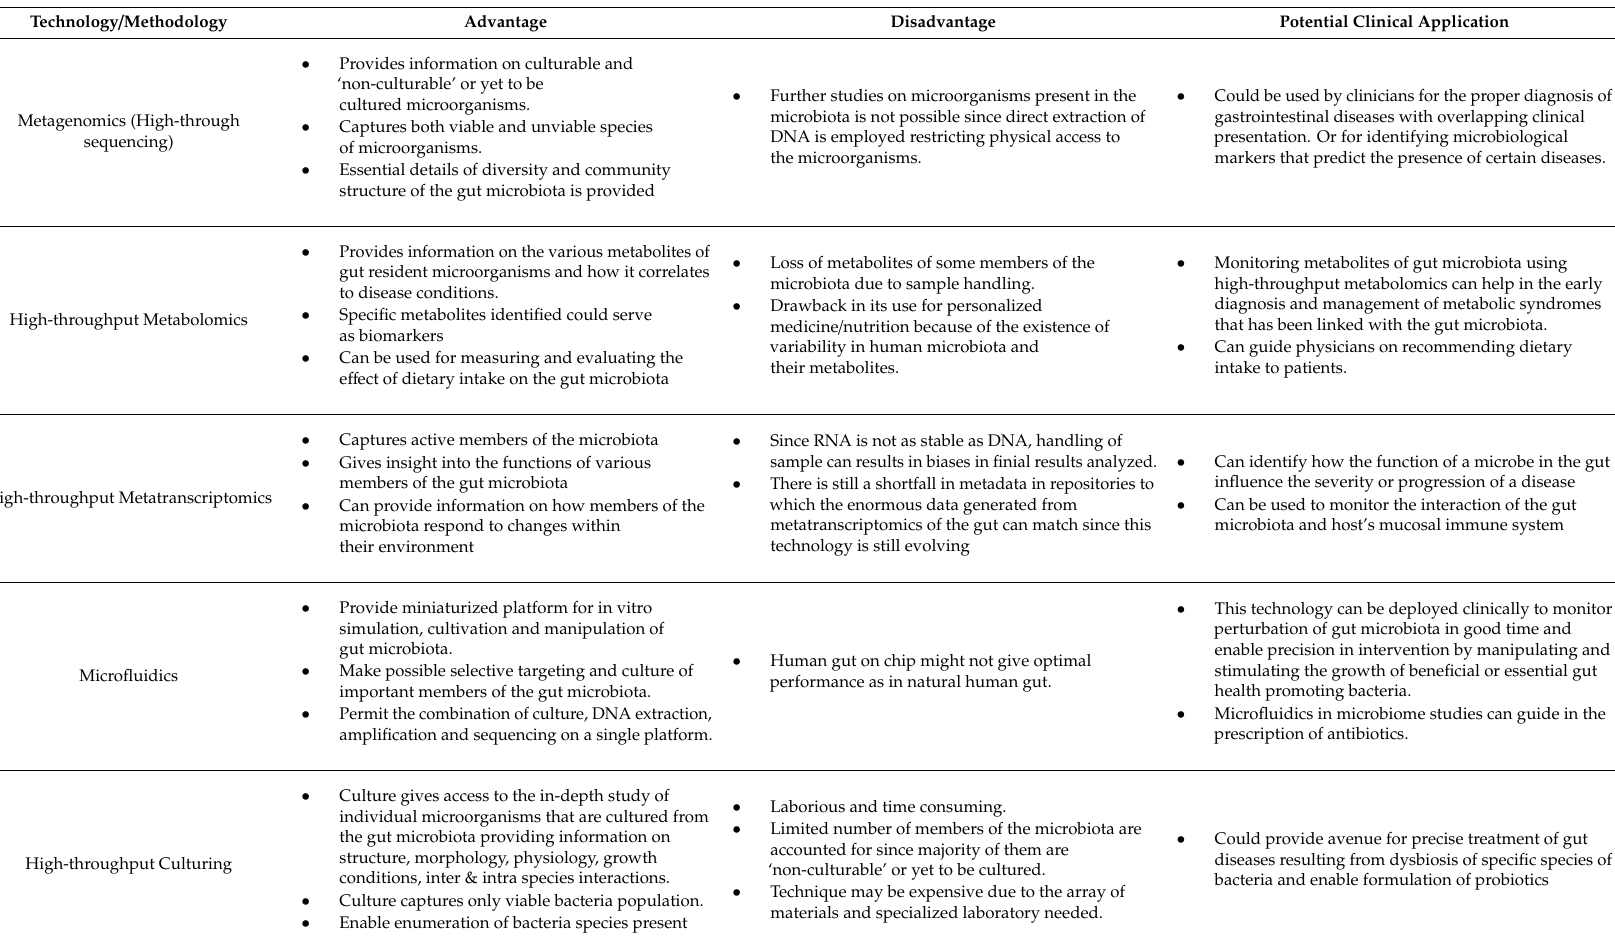
Table 3. Summary of the Potential Clinical Application of Various Technologies and Their Advantages and